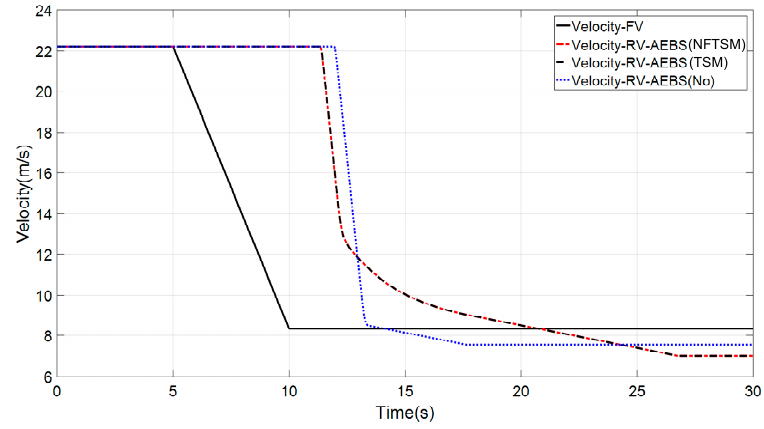
Figure 7. Comparison of relative speed.